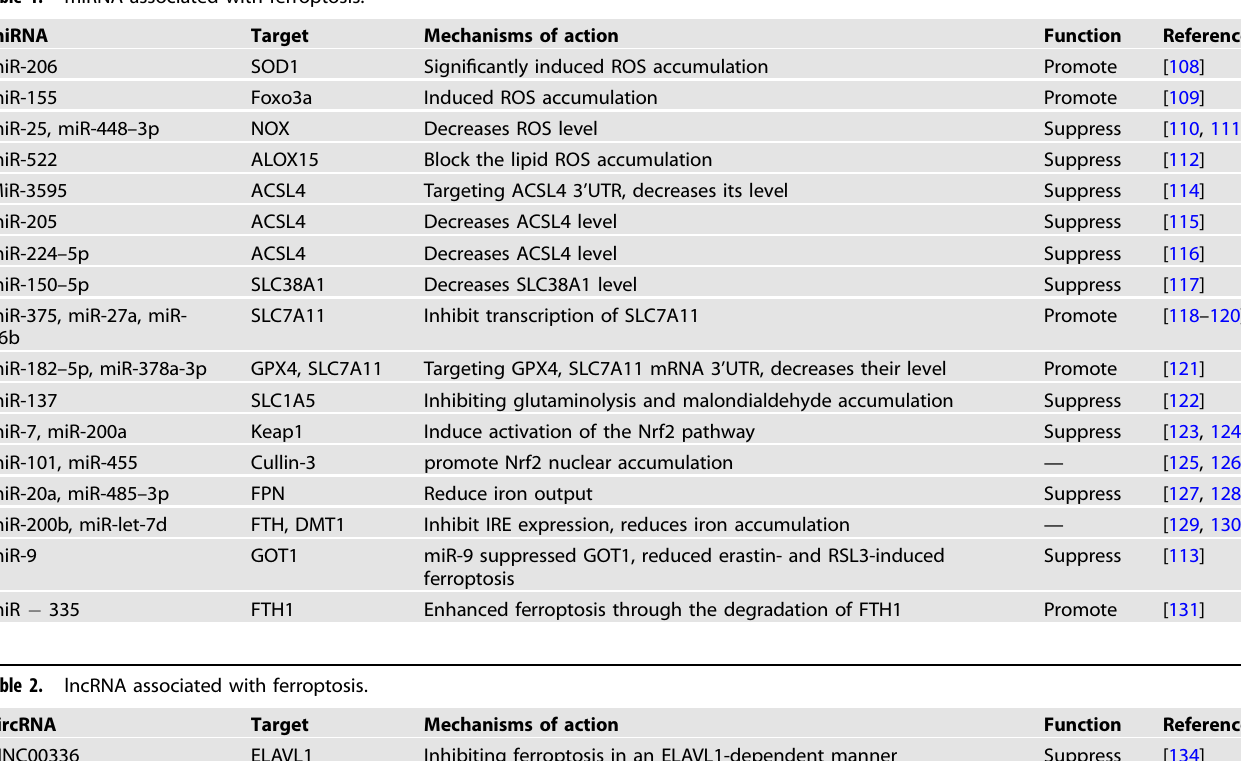
Table 1. miRNA associated with ferroptosis.